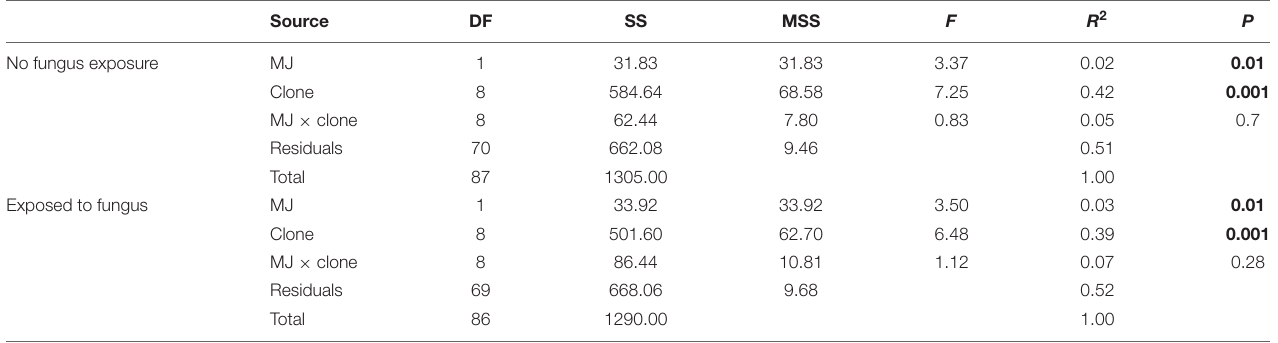
TABLE 2 | Multivariate analysis of variance (MANOVA) results (DF, degrees of freedom; SS, Sum of Squares; MS, Mean Squares; F , F -value; R 2 , adjusted R -squared; and P , p -value). Source DF SS MSS F R 2 P No fungus exposure MJ